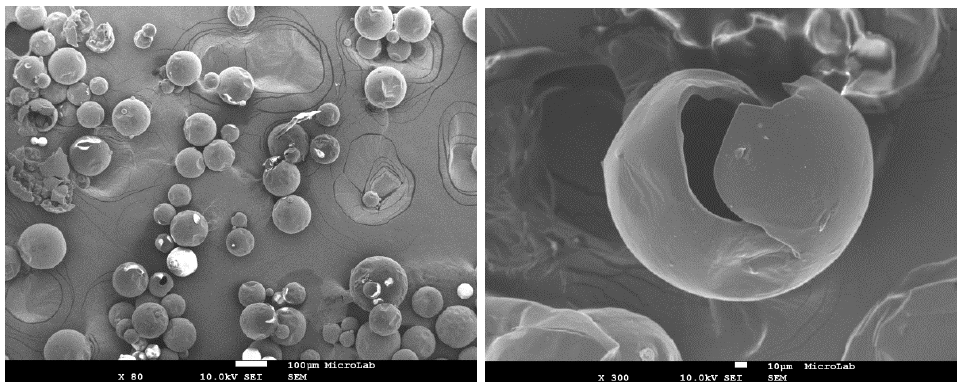
Figure 2. SEM image of AT MCs (Active H source: aminosilane and TEOS). The image on the right displays a broken MC which demonstrates the core–shell morphology typical of these MCs. Scale bar = 10 µ m.